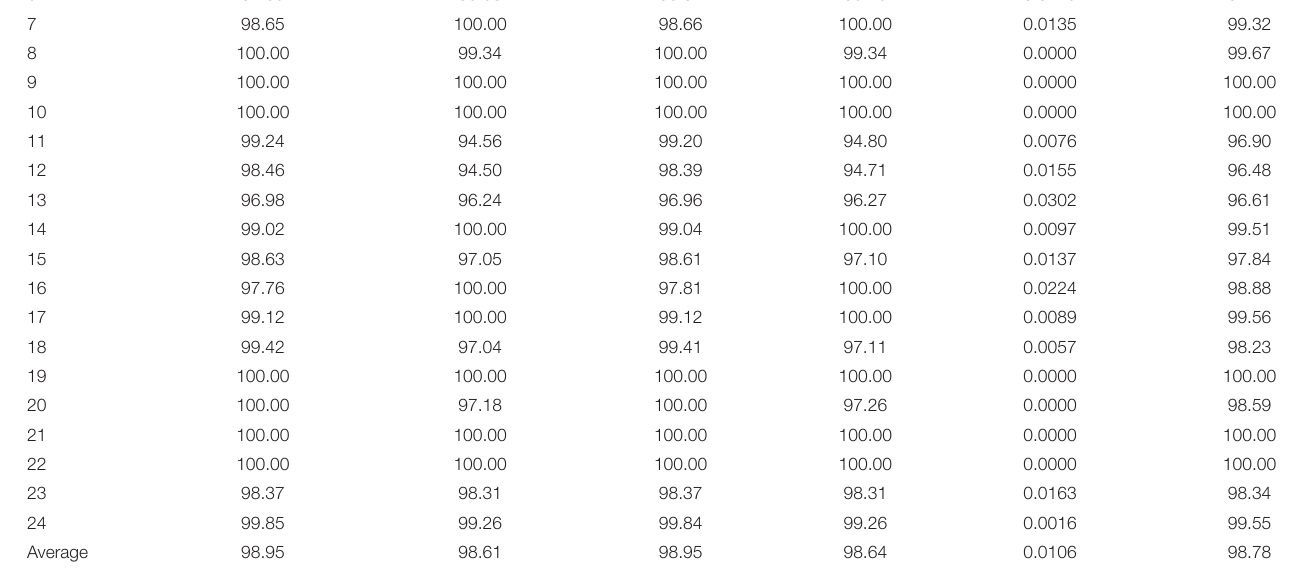
TABLE 1 | Specific indicators of samples are shown in the table.